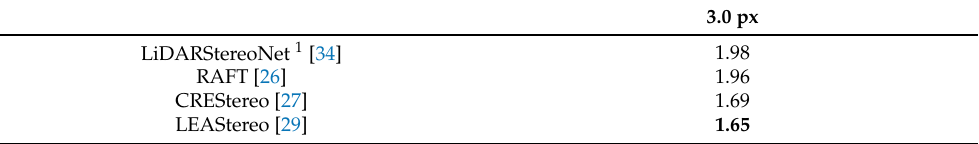
Table 3. Comparison of the methods that have been tested on the KITTI stereo dataset showing the percentage of pixels with an error greater than 3 pixels. The result with the highest accuracy is shown in bold.